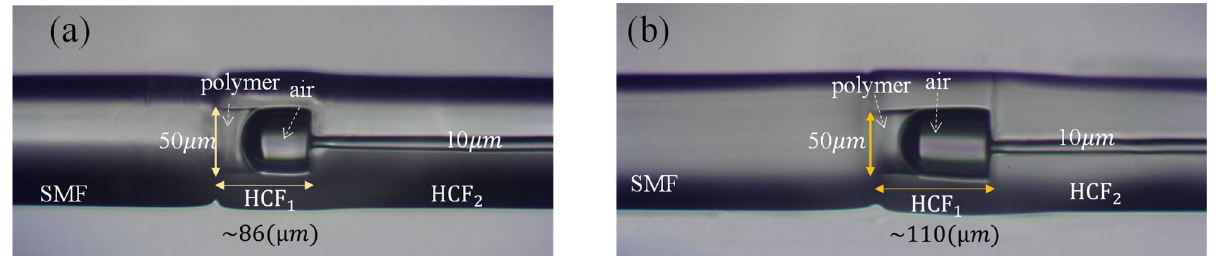
Figure 2. Micrographs of the proposed DCFFPIs with various structures with lengths of ( a ) HCF 1 = 86 μ m and ( b ) HCF 1 = 110 μ m. Here, HCF 1 : (D = 50 μ m) and HCF 2 : (D = 10 μ m).